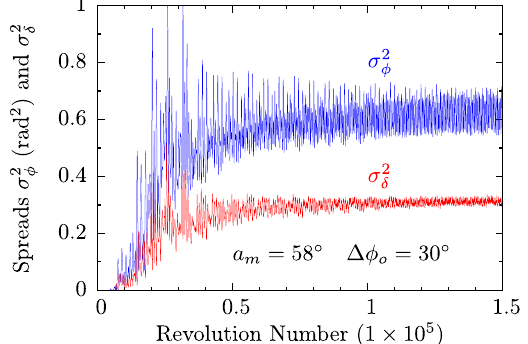
FIG. 9. Squared of the longitudinal bunch sizes as functions of ¼ 58 ° and Δ ϕ ¼ 30 ° as the diffusion revolution number for a m o process evolves. The evolution starts out linearly with time and equilibrates after about 1 . 5 × 10 5 revolutions.